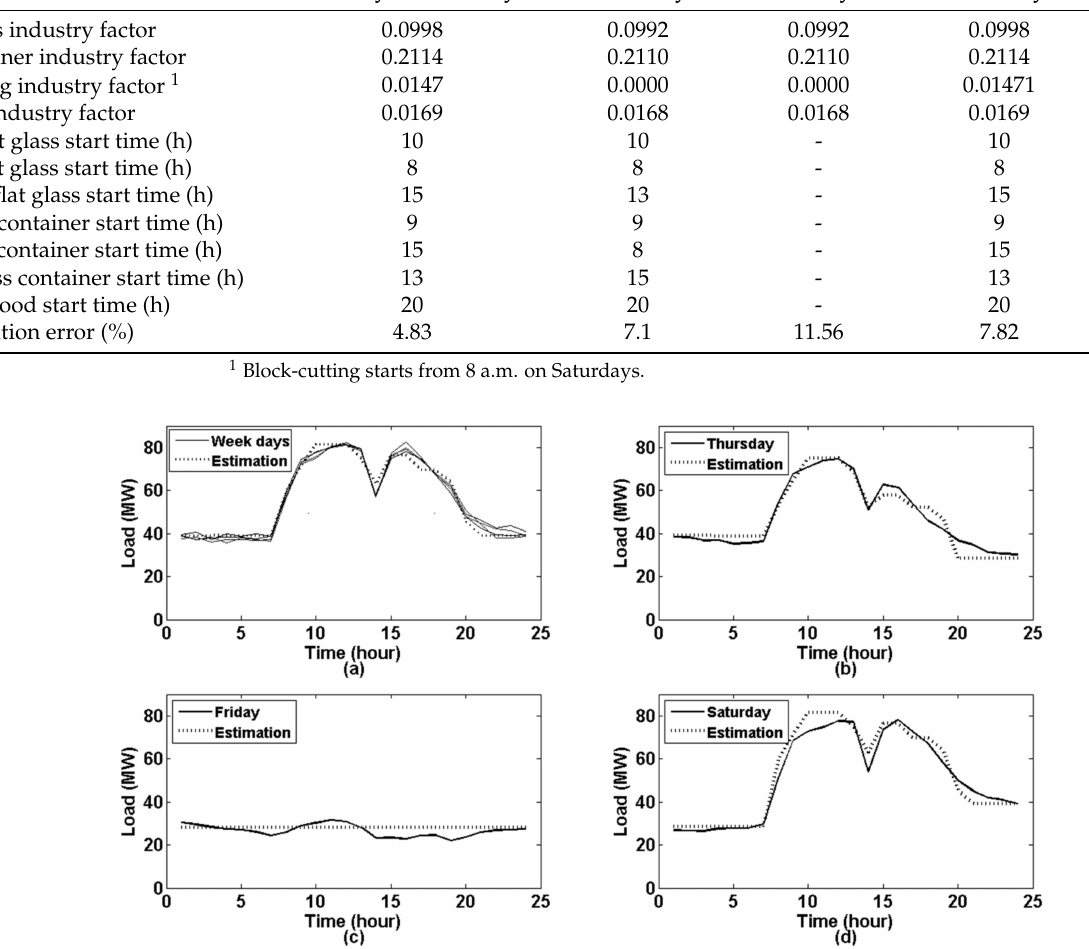
Figure 4. Estimated load curve vs. real load curve: ( a ) weekday (Sunday to Wednesday); ( b ) Thursday; ( c ) Friday; ( d )